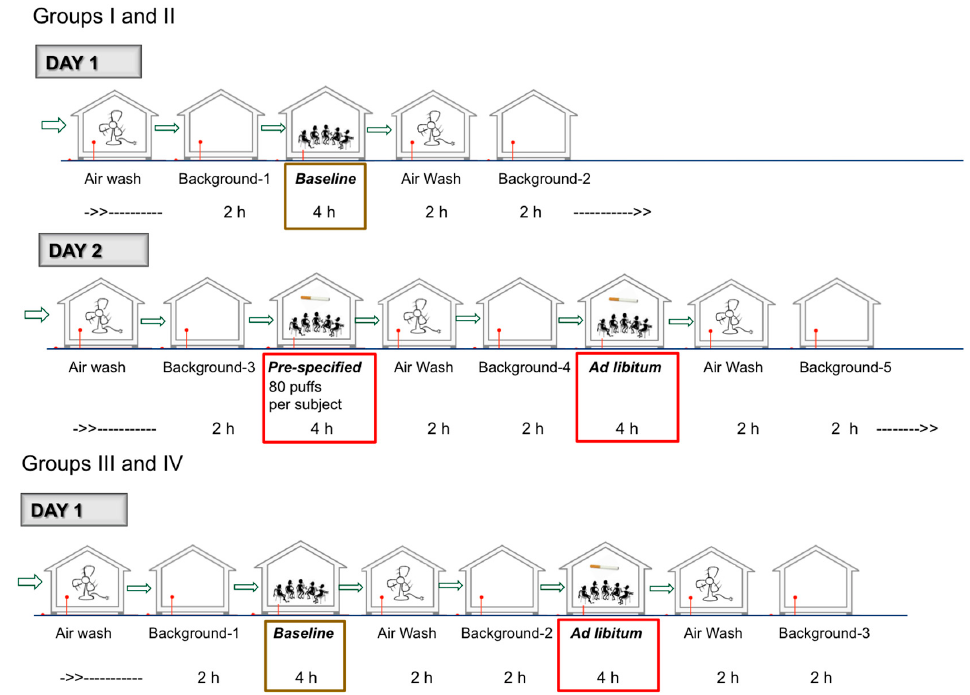
Figure 1. Overall Study Conduct and Sampling Schedule.